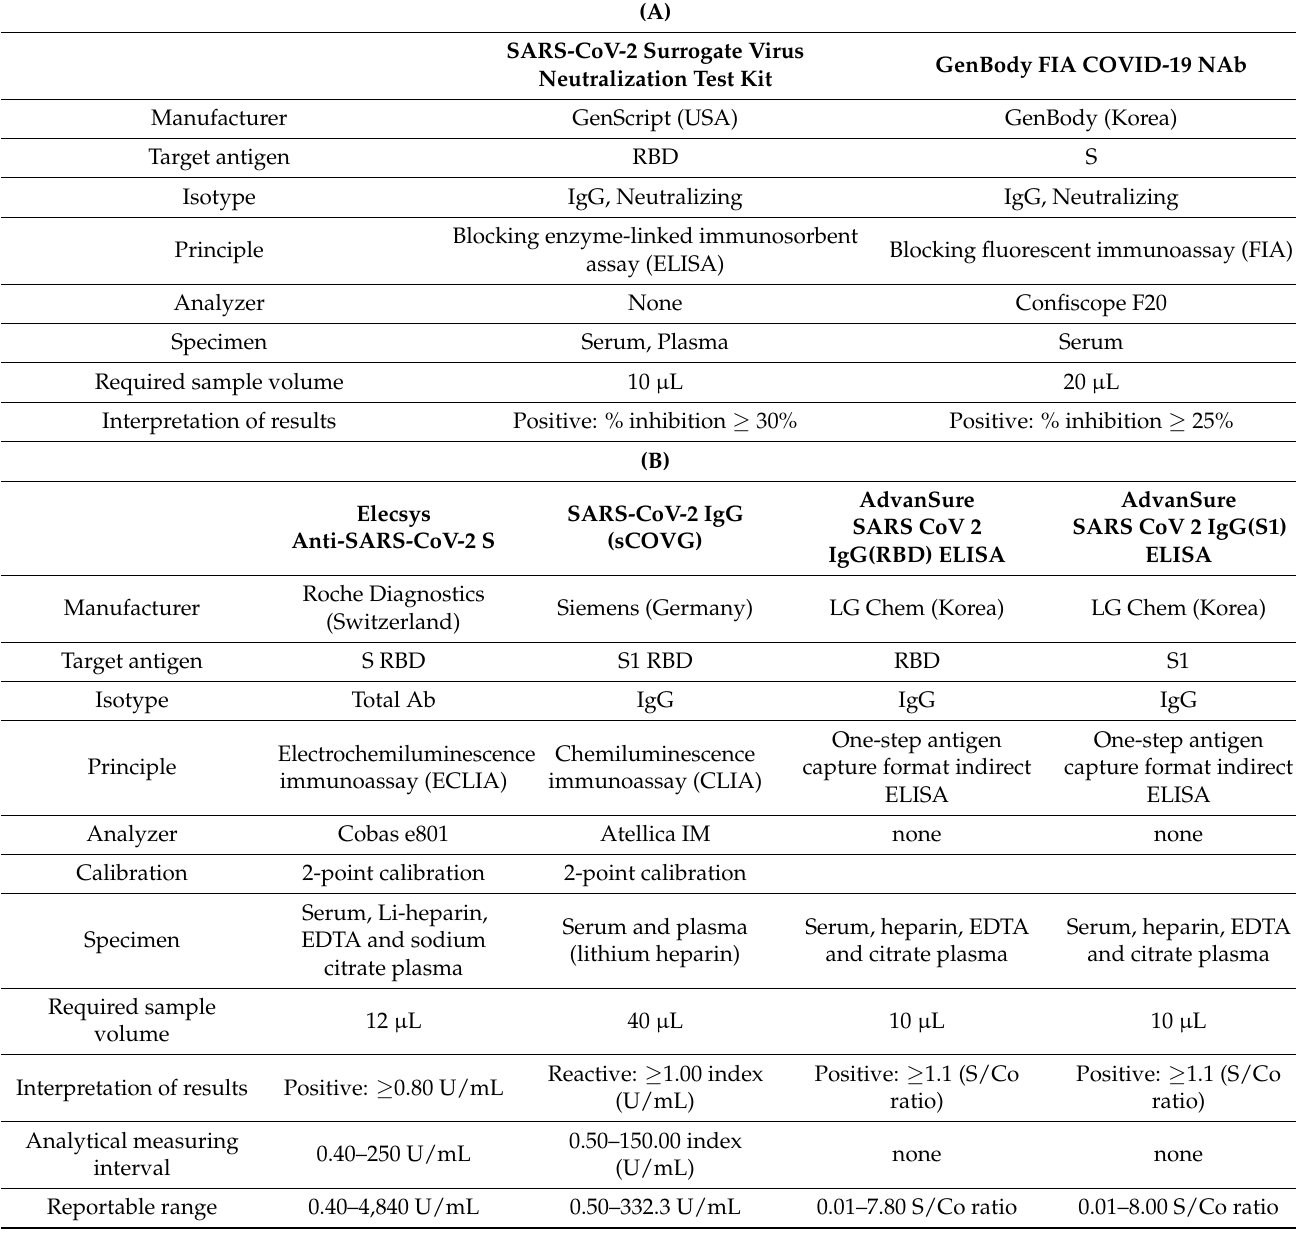
Table A2. Characteristics of two surrogate virus neutralization tests (A) and four SARS-CoV-2 binding